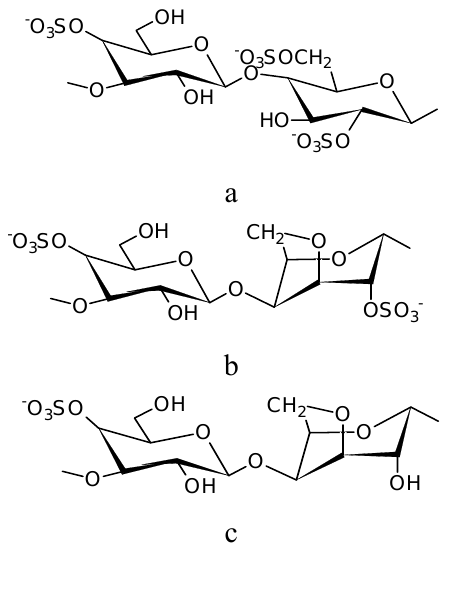
Figure 5. Chemical structure of a) λ -carrageenan, b) ι -carrageenan and c) κ